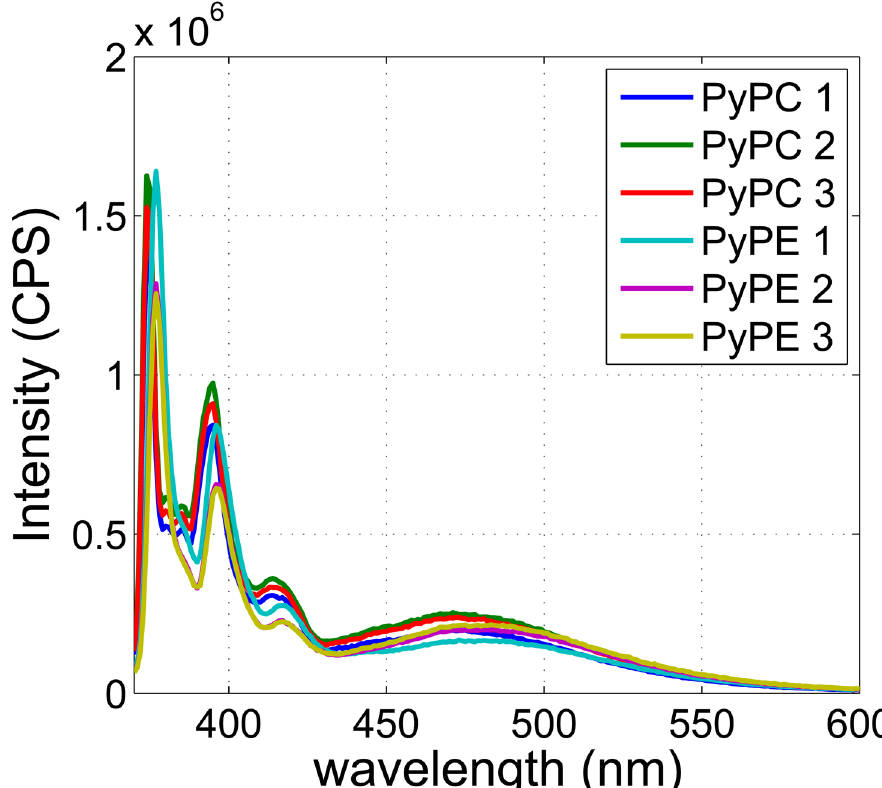
Fig 3. Emission spectra of liposomes containing 0.5 mol % PyPC and PyPE. Three PyPC based liposome samples ( ‘ PyPC 1 ’ , ‘ PyPC 2 ’ , ‘ PyPC 3 ’ ) and PyPE based liposome samples ( ‘ PyPE 1 ’ , ‘ PyPE 2 ’ , ‘ PyPE 3 ’ ) were made. The same total lipid (DPPC, PyPC and PyPE) concentration (1.28 mM) was used in all cases. CPS: counts per